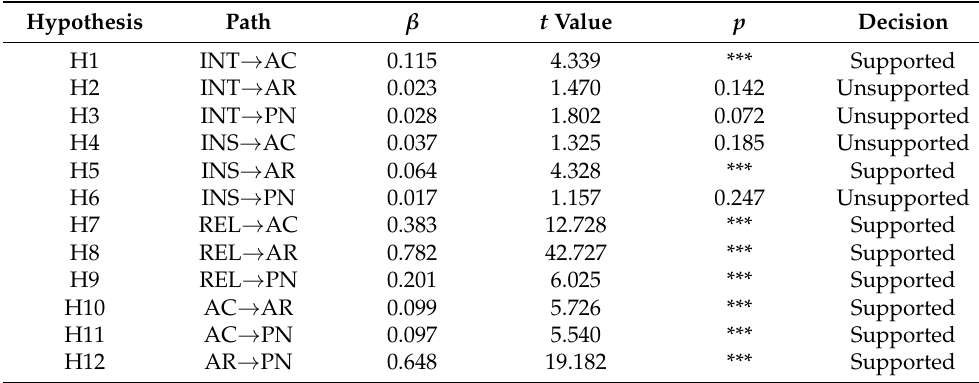
Table 6. Results of the path coefficient analysis and hypothesis testing (direct